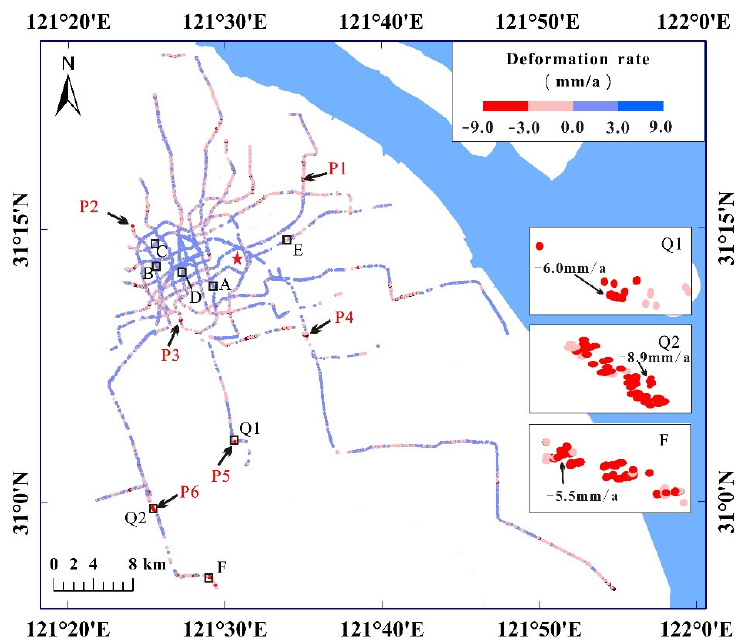
Figure 7. The ground deformation rate along the subways in Shanghai derived from InSAR between 2013 and 2020. The red five-pointed star represents the position of the reference point.